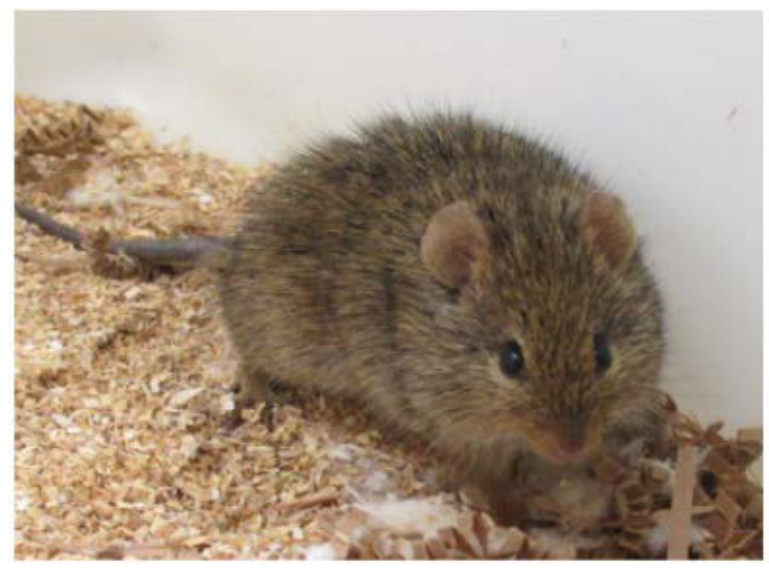
Figure 1. Young adult male Nile rat at approximately 90–100 g bedded on BetaChip.